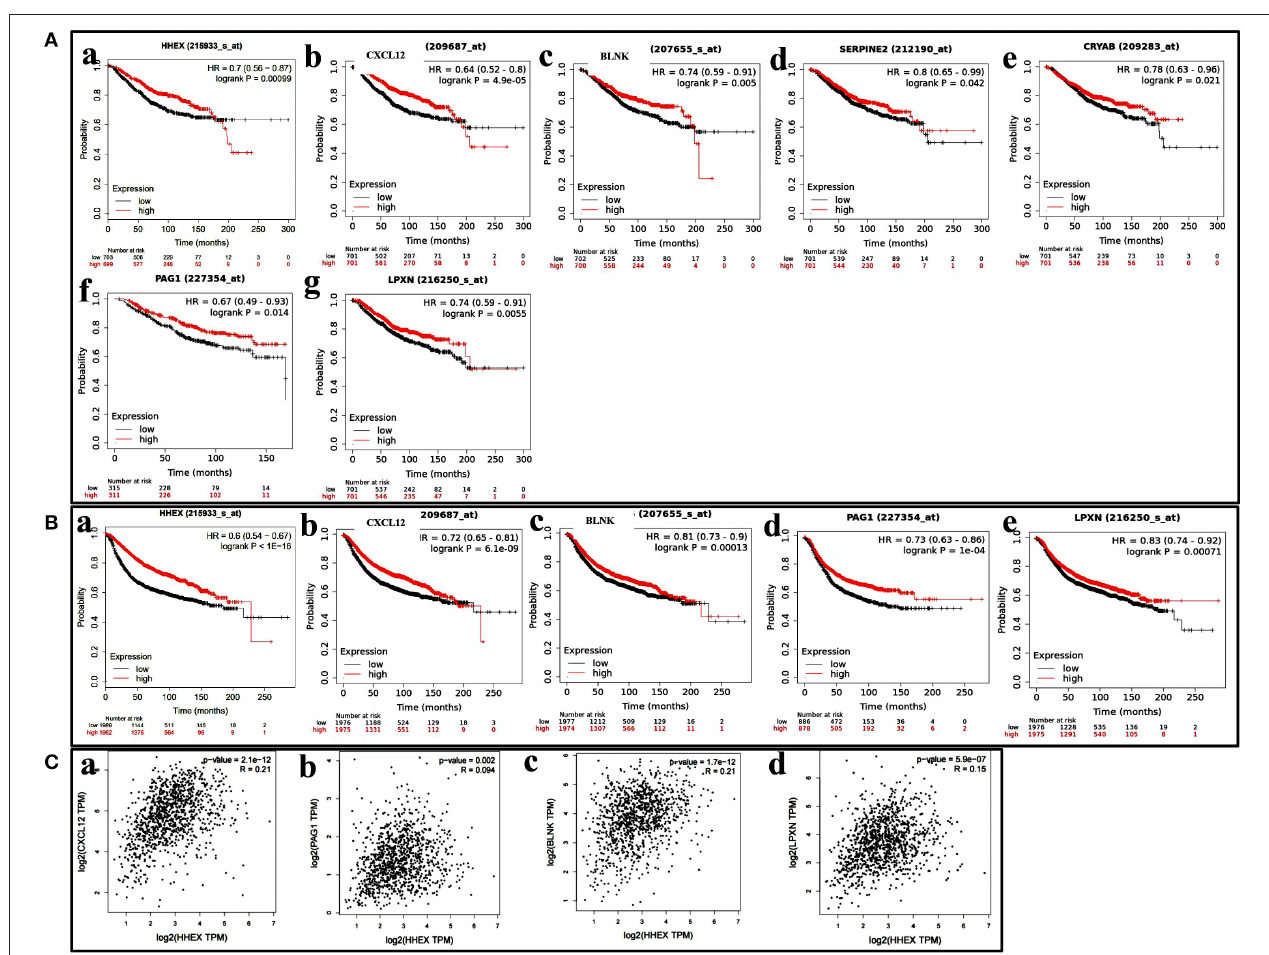
FIGURE 5 | Potential regulatory mechanism of HHEX in breast cancer (BC). (A,B) Kaplan–Meier plotter reveals the overall survival and Relapse-free survival curves based on the mRNA level of CXL12, BLNK, PAG1, and LPXN in BC patients. (C) The positive correlation between HHEX expression and CXL12, BLNK, PAG1, and LPXN by